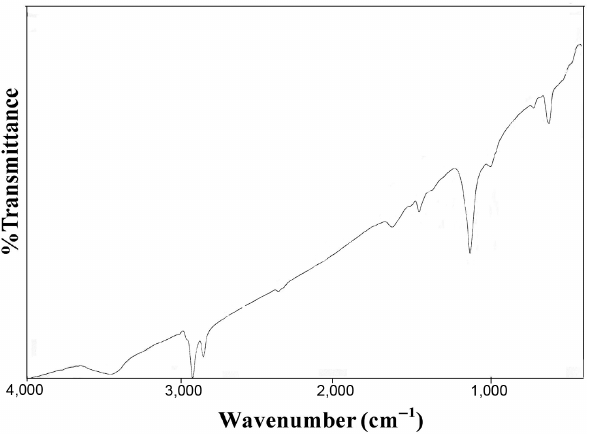
Figure 4: FT-IR spectra of CdS